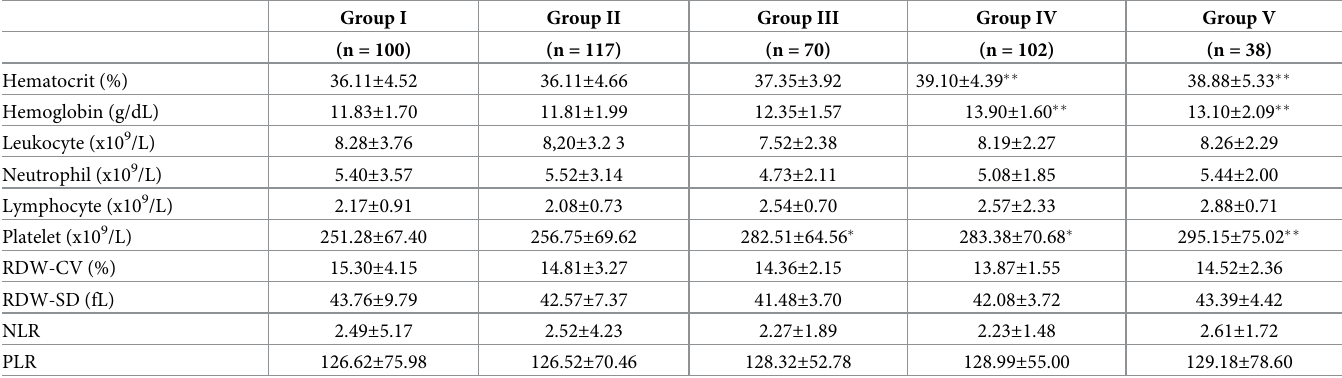
Table 2. Hemogram parameters in